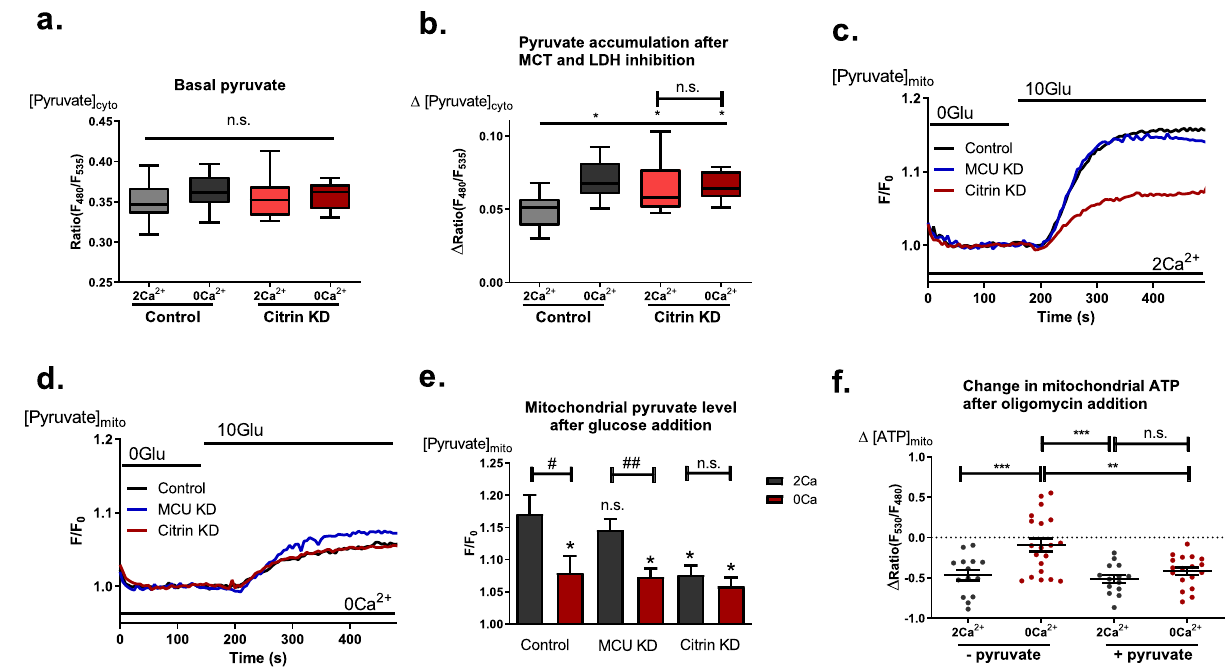
Fig. 7 Citrin activity regulates pyruvate ’ s fate. a Basal cytosolic pyruvate levels measured with Pyronic in control vs. knockdown of citrin in the presence and absence of extracellular Ca 2 + (One-Way ANOVA with Tukey ’ s multiple comparison test, n = 9 for control 2 Ca 2 + and 0 Ca 2 + , n = 10 for citrin KD 2 Ca 2 + and 0 Ca 2 + ; b Cytosolic pyruvate accumulation in response to LDH and MCT inhibition with GSK 2837808A and AR-C155858, respectively (One- Way ANOVA with Tukey ’ s multiple comparison test, * p < 0.05, n = 9 for control 2 Ca 2 + and 0 Ca 2 + , n = 10 for citrin KD 2 Ca 2 + and 0 Ca 2 + ). c Representative traces of mitochondrial pyruvate measurements with mito-PyronicSF in the presence of extracellular Ca 2 + under control, citrin KD and MCU KD conditions. d Representative traces of mitochondrial pyruvate measurements with mito-PyronicSF in the absence of extracellular Ca 2 + under control, citrin KD and MCU KD conditions. e Statistical analysis of mitochondrial pyruvate measurements as shown in c and d (One-Way ANOVA with Tukey ’ s multiple comparison test, n = 11 for control 2 Ca 2 + , n = 10 for control 0 Ca 2 + , n = 12 for MCU KD 2 Ca 2 + , n = 8 for MCU KD 0 Ca 2 + , n = 14 for citrin KD 2 Ca 2 + , n = 7 for citrin KD 0 Ca 2 + , * p < 0.05, n.s. p > 0.05; unpaired t -test, # p < 0.034, ## p = 0.006, n.s., p = 0.463). f Comparison of mitochondrial ATP dynamics after 2 µ M oligomycin addition in the presence and absence of extracellular Ca 2 + ±1 mM pyruvate supplementation (One- Way ANOVA with Tukey ’ s multiple comparison test, ** p < 0.01, *** p < 0.001, n = 14 for 2 Ca 2 + no pyruvate), 20 for 0 Ca 2 + no pyruvate, 14 for 2 Ca 2 + pyruvate, 18 for 0 Ca 2 +